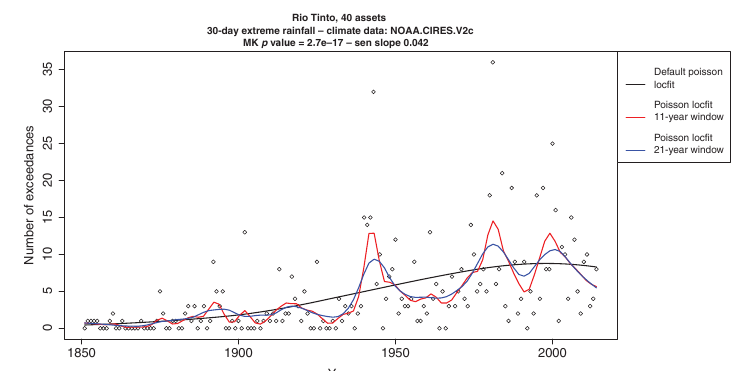
Figure 4. Time series N t (p , d) of the yearly number of 30-day extreme rainfall events exceeding the 10-year return level for the Rio Tinto portfolio computed using the 20CR dataset, using 3 windows (11, 21, and 114 years) to illustrate different aspects of long-term variability.